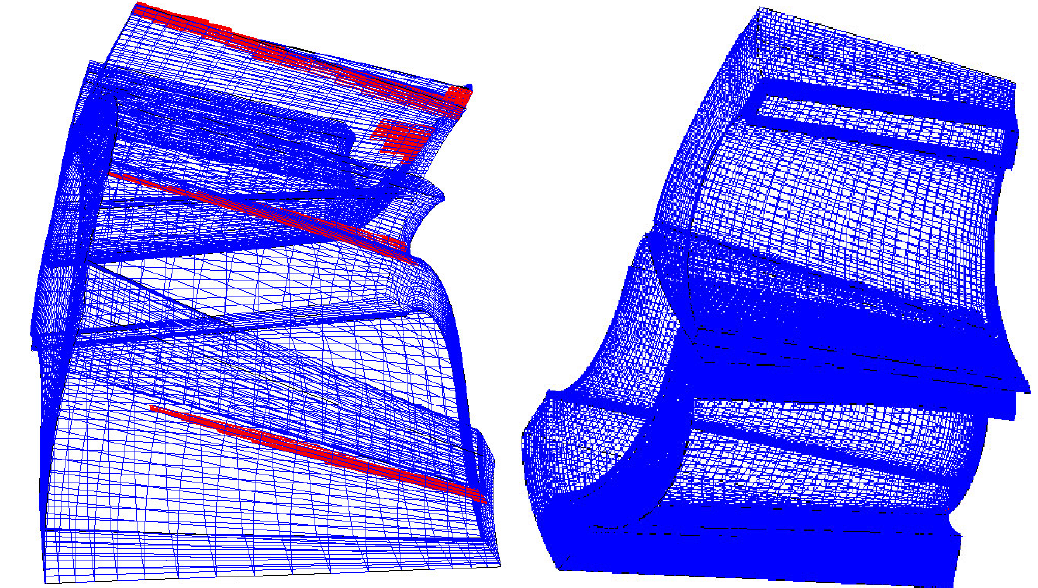
Figure 13. Typical CFD mesh quality distribution graph — number of elements versus Jacobian determinant det(J) ratio Figure 14 illustrates an example of the correction of a low-quality mesh with volumes with a low